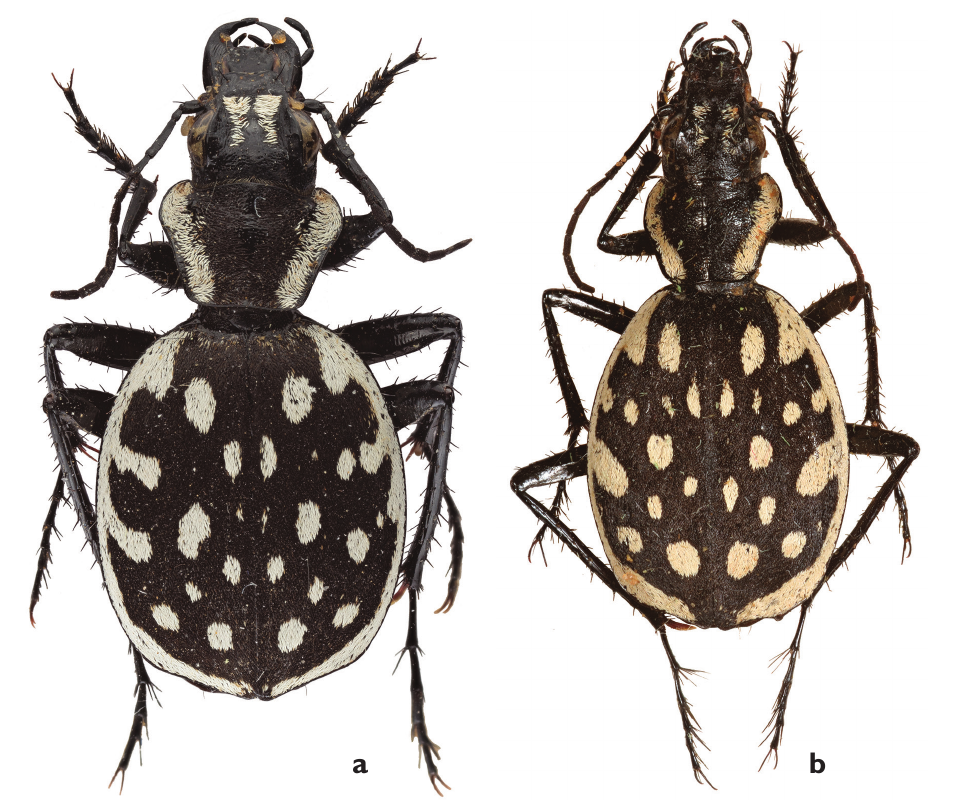
a b Figure 27. Dorsal habitus of Graphipterus : a G. sharonae sp. n. b G. stagonopsis sp. n. Median lobe of aedeagus with bent tip (Fig. 9p). Habitat.